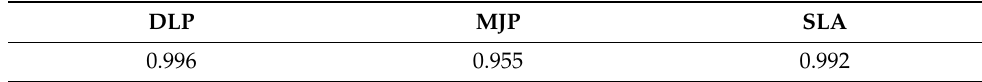
Table 7. Intraclass Correlation Coefficient (ICC) values of 3D-printed models.